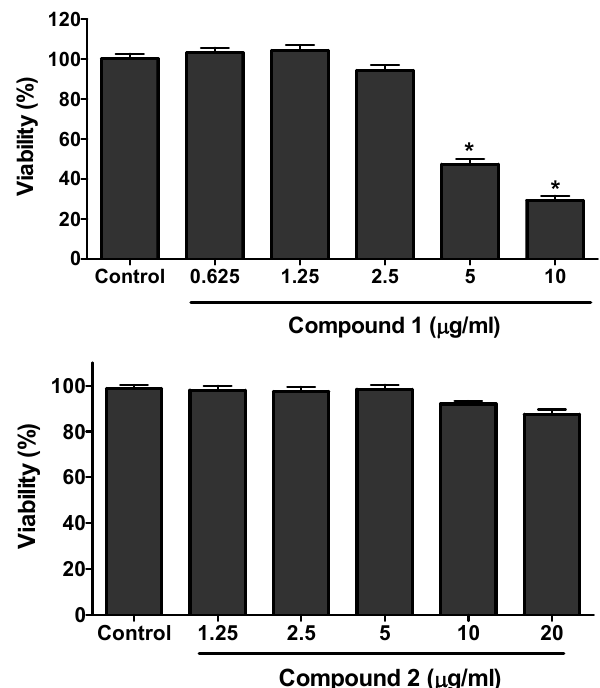
Figure 4. 3T3-L1 cell viability assay of compounds 1 and 2 . The preadipocytes cells of 3T3-L1 were cultured and seeded in 96-well plate. After two days of confluence, the cells were treated with or without different concentration of compounds 1 and 2 and cell viability was determined by MTT-assay. The data show relative mean viability percentage ± SD of triplicate experiments. Statistical significance was calculated using one-way ANOVA followed by Dunnett’s test. * P < 0.05 vs. control.